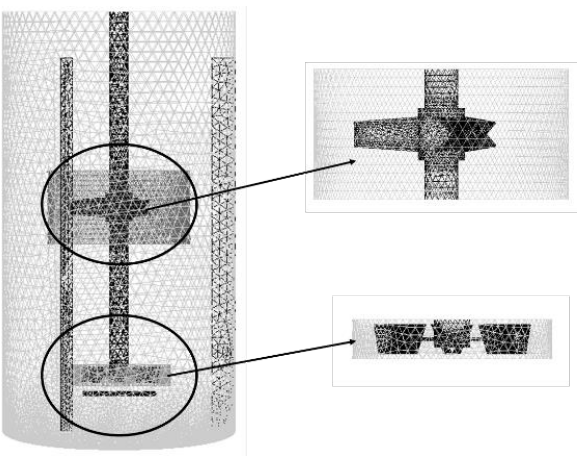
Figure 2. Schematic Diagram of Grid Division of Industrial Scale Stirred Reactor.